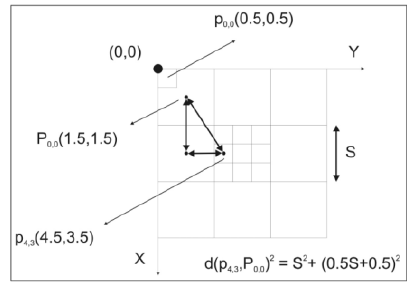
Figure 1. Illustration of coordinates of pixel and sub-pixel and distance calculation between them (adopted from Mertens (2008))